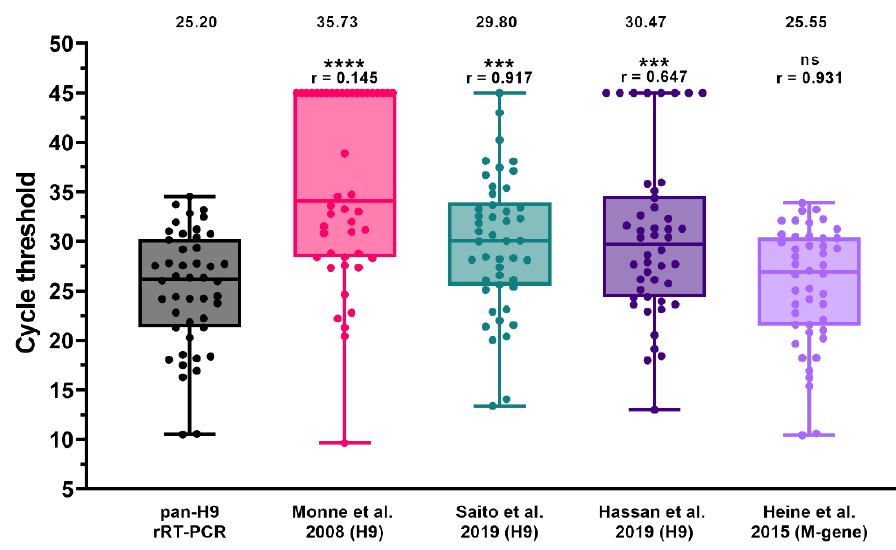
Figure 2. Diagnostic sensitivity of the pan-H9 rRT-PCR compared to M-gene screening rRT-PCR (Heine at al., 2015) and three existing H9 detection methods. Dots represent individual Ct values. Negative samples were arbitrarily assigned a value of 45. Mean Ct and Spearman’s rank correlation coefficient (r) are reported. **** p < 0.0001; *** p < 0.0002; ns: not significant.